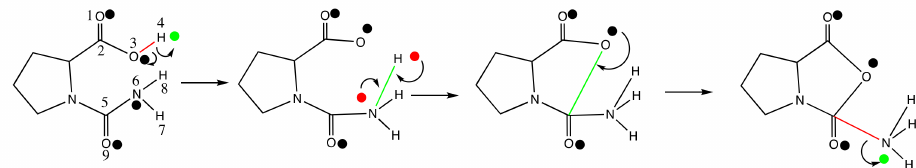
Scheme 9. Curly arrow representations of the main electron density flows of the reaction from 8 to 9 .